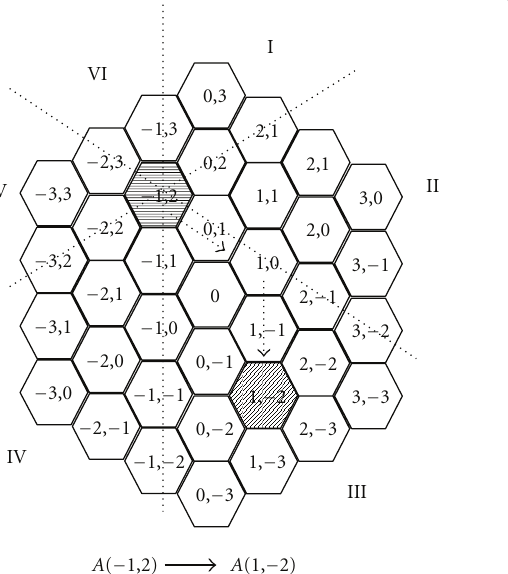
Figure 5: Mapping example.